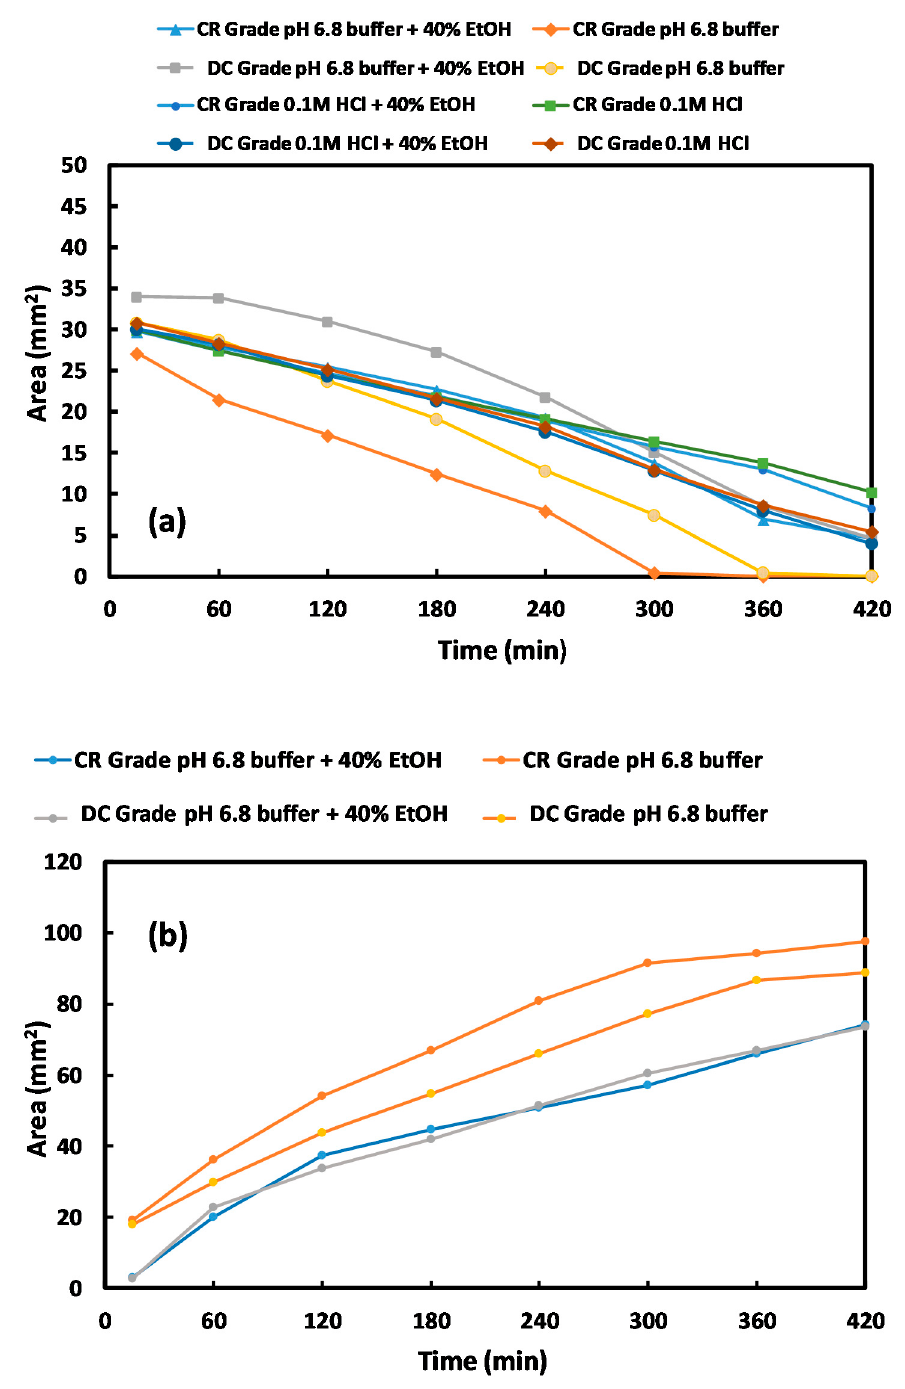
Figure 8. ( a ) Diminution of the mean dry core area of CR and DC formulations using MRI images, ( b ) development of mean gel area of CR and DC formulations using MRI images (experiments conducted in pH 6.8 and pH 6.8 (40% absolute ethanol)).